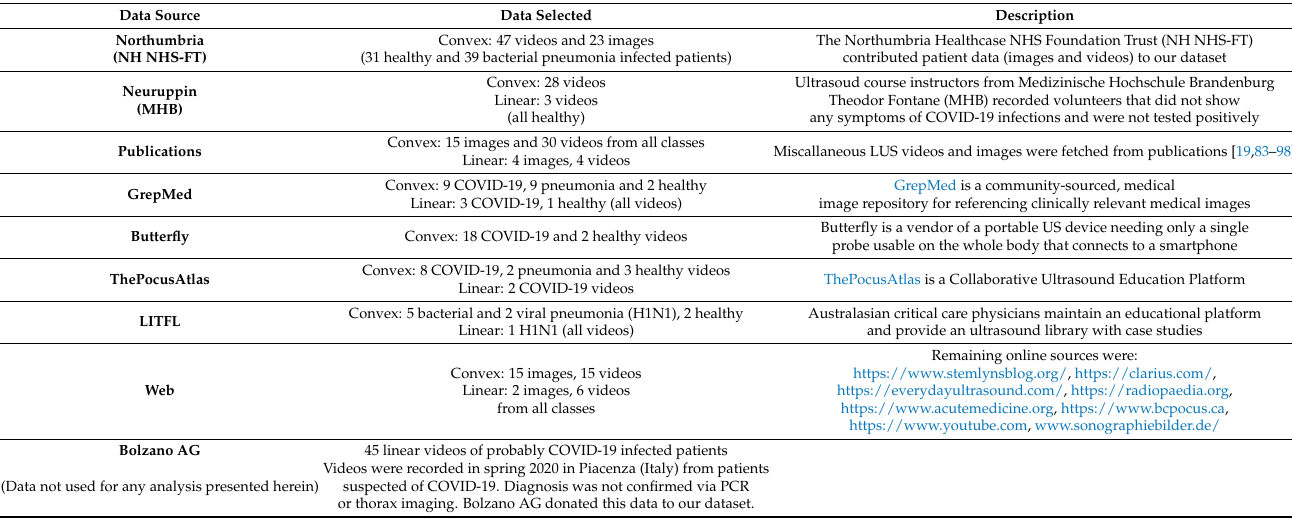
Table A1. Data sources. Overview of all data sources, including a comprehensive list of publications and educational websites that provide data included in our